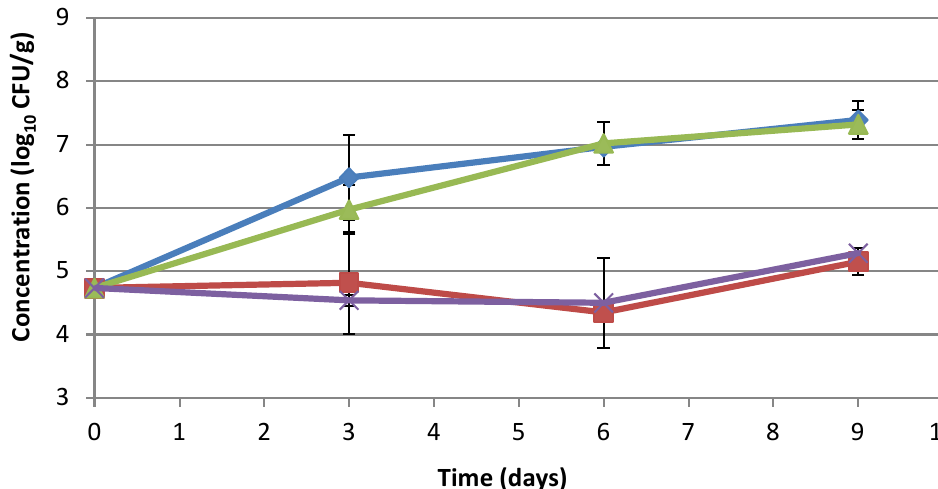
Figure 4. Effect of fermented tomato byproduct extract on B. cereus in minced pork meat. Behavior of B. cereus in minced pork meat with or without fermented byproduct tomato extract/preservatives determined through microbial challenge test. B. cereus concentration in minced pork meat (blue line), minced pork meat with 1.6% fermented byproduct tomato extract (red line), minced pork meat with 1.2% sodium lactate (green line), and minced pork meat with 2.5% sodium lactate/sodium diacetate (96:4) (purple line). Concentration is expressed as log 10 CFU/g.